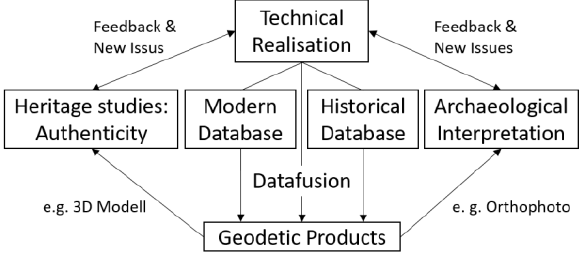
Figure 2: Interdisciplinary cooperation to produce and evaluate technical products for archaeological interpretations and heritage studies.